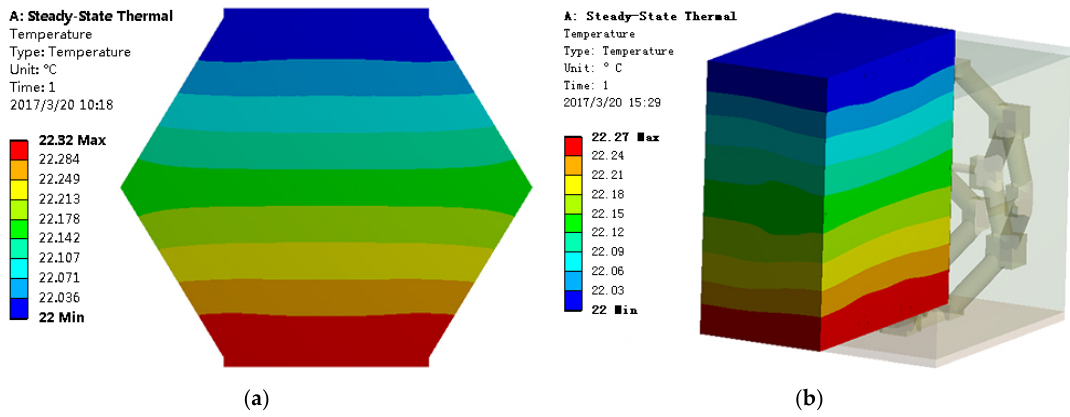
Figure 4 . The temperature distribution of the composite for porosity of 95%: ( a ) 2D C ‐ M model; ( b ) Figure 4. The temperature distribution of the composite for porosity of 95%: ( a ) 2D C-M model; ( b ) 3D 3D B ‐ P model. B-P model. Table 2. Effective thermal conductivity in 2D C-M model.